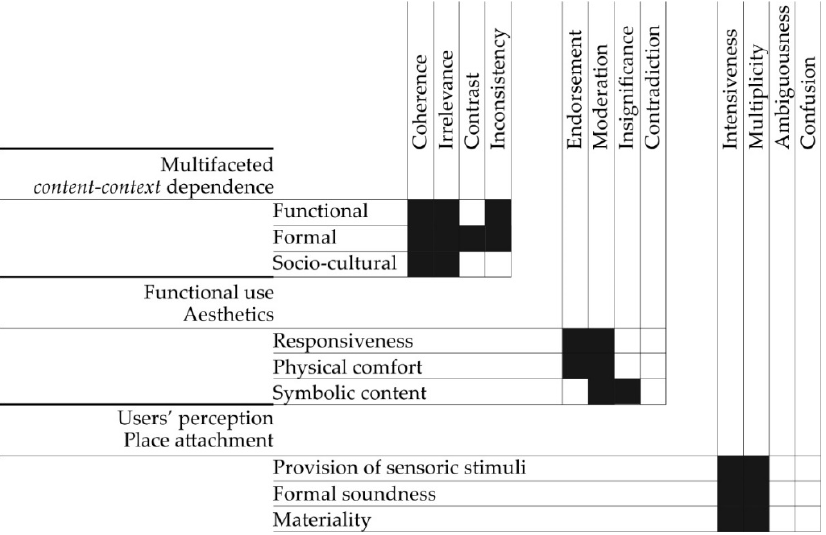
Figure 9. Summary of singular characteristics of four selected cases in the three examined areas of relation.